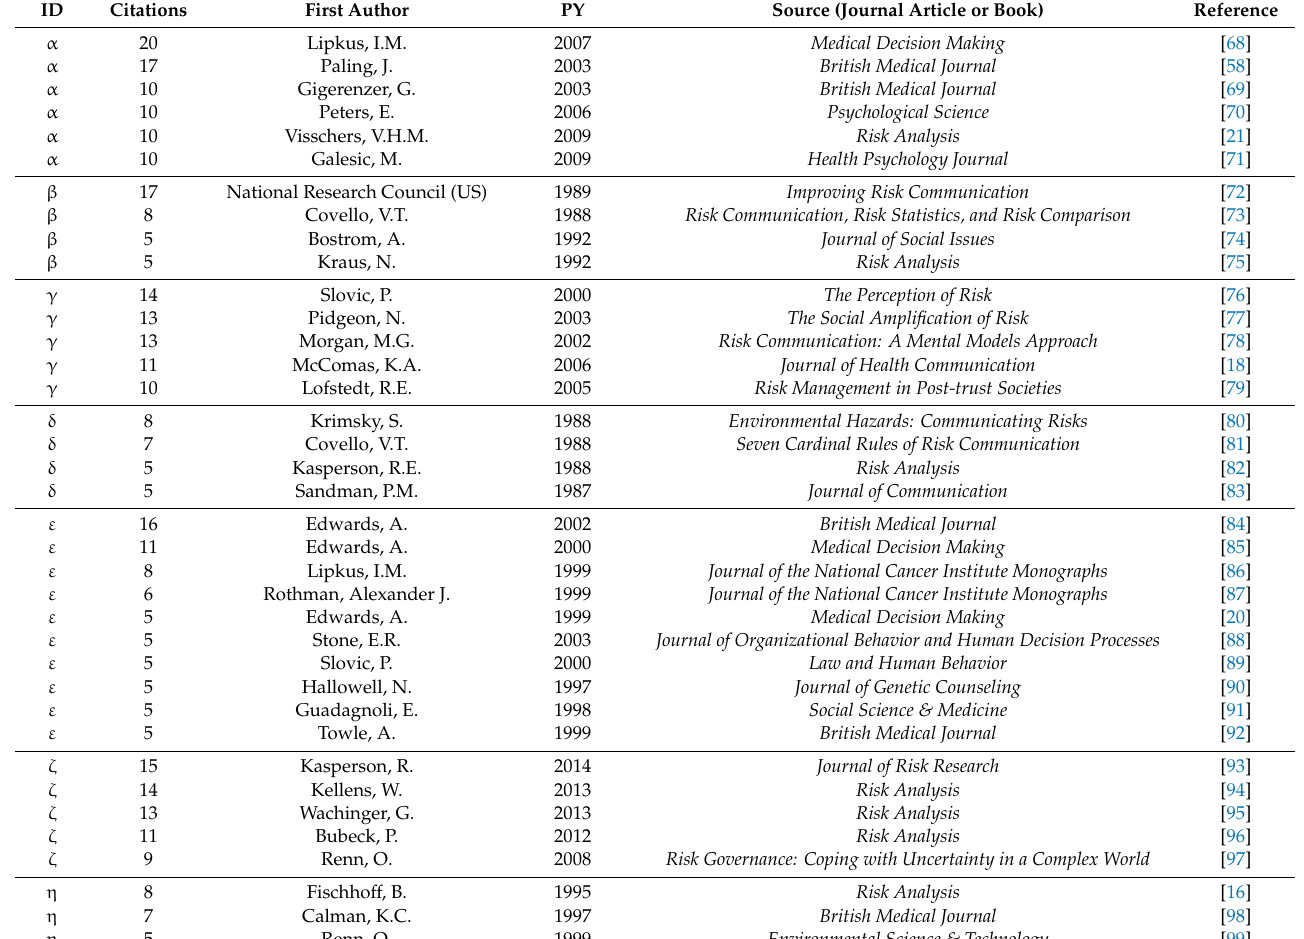
Table 9. Top five highly cited references with at least five citations received in the largest co-citation clusters (NP > 50) of Figure 10, see also Table